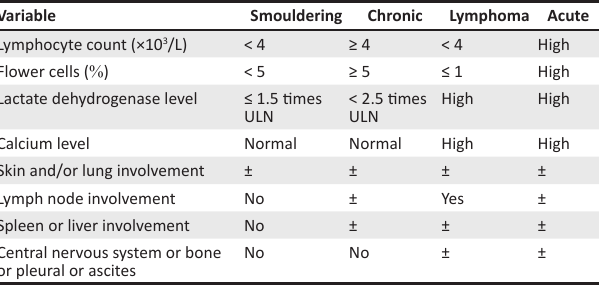
TABLE 1: Diagnostic criteria for clinical subtypes of adult T-cell leukaemia or lymphoma.